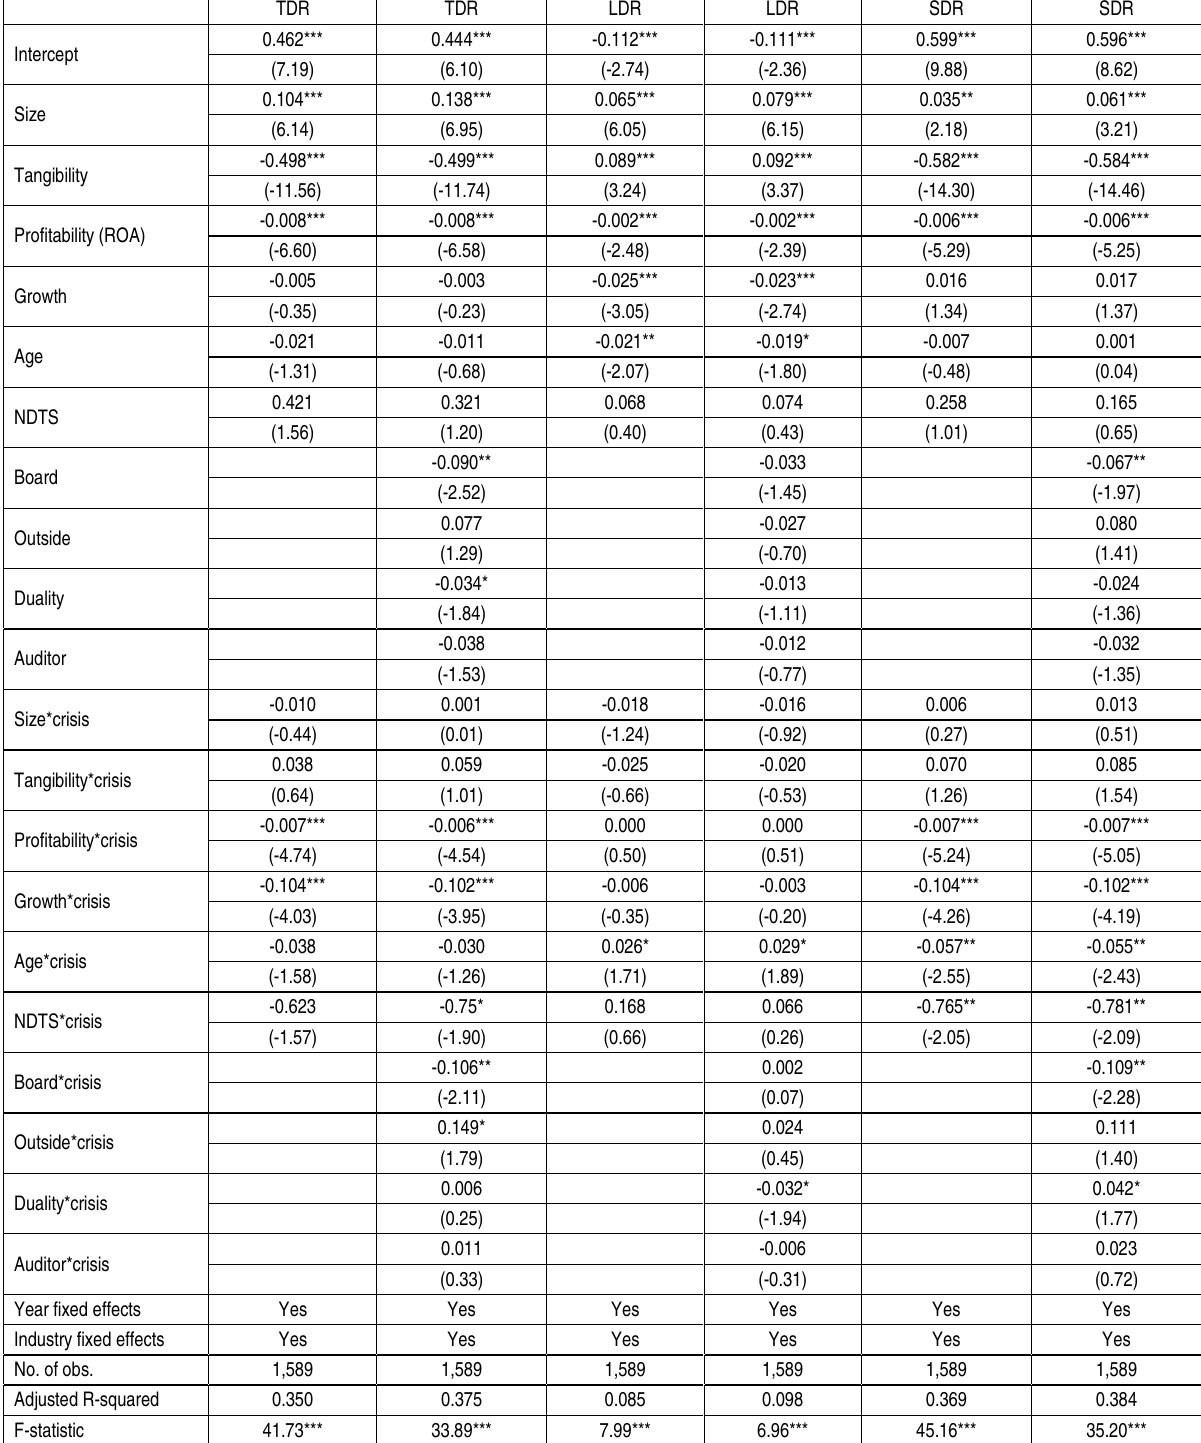
Table 2. Panel regression results in the pre-crisis and debt crisis